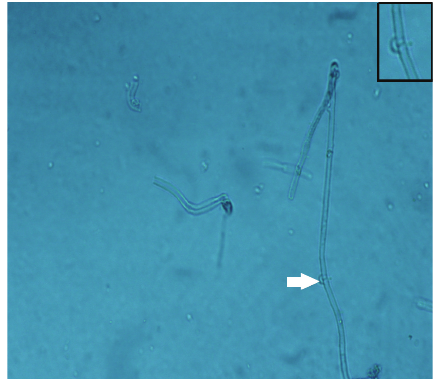
Figure 4: LPCB mount shows hyaline septate hyphae, with clamp connections, seen in the inset (Magnification